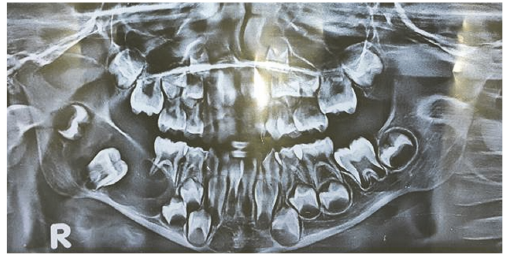
Figure 2: Orthopantomogram reveals radiopaque lesion sur- rounded by a radiolucent zone extending anteriorly from the lower first molar region to body of the mandible posteriorly on the right